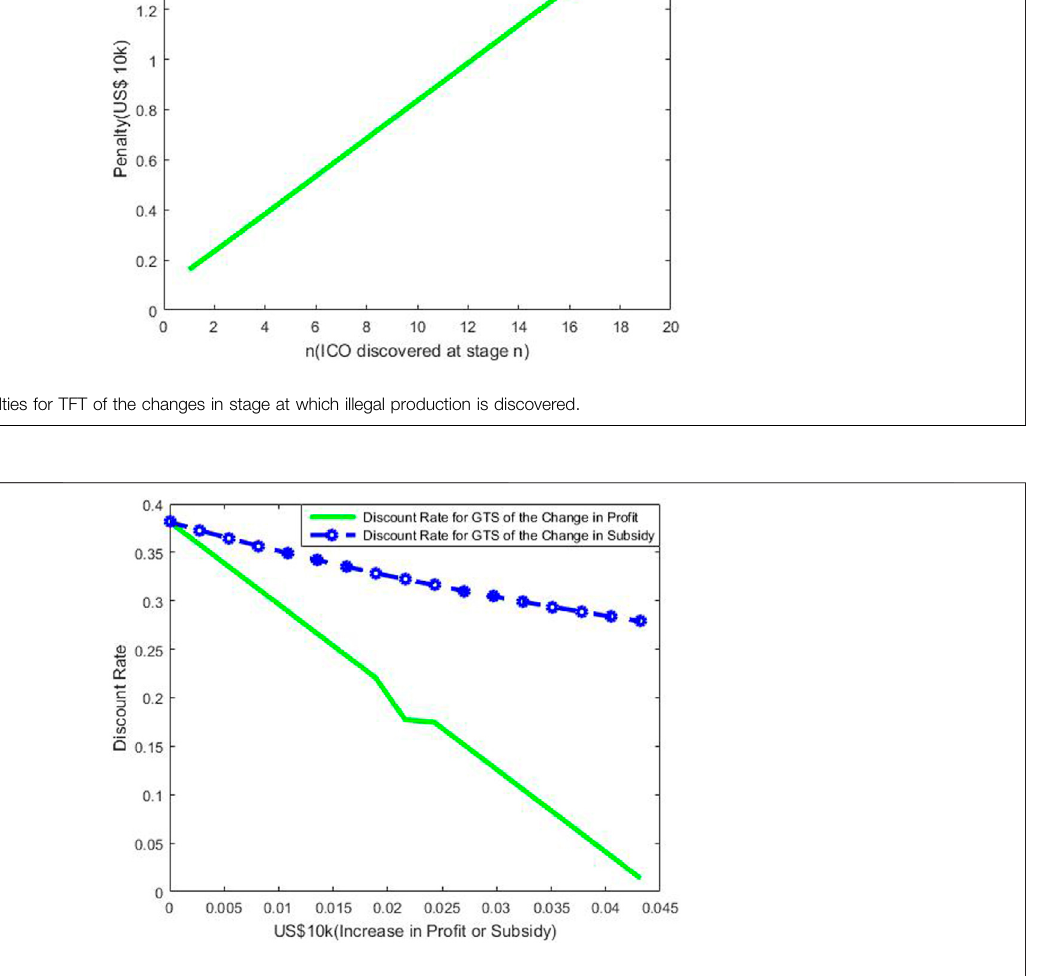
FIGURE 5 | Discount rate comparison for GTS of the changes in pro fi t and subsidy.